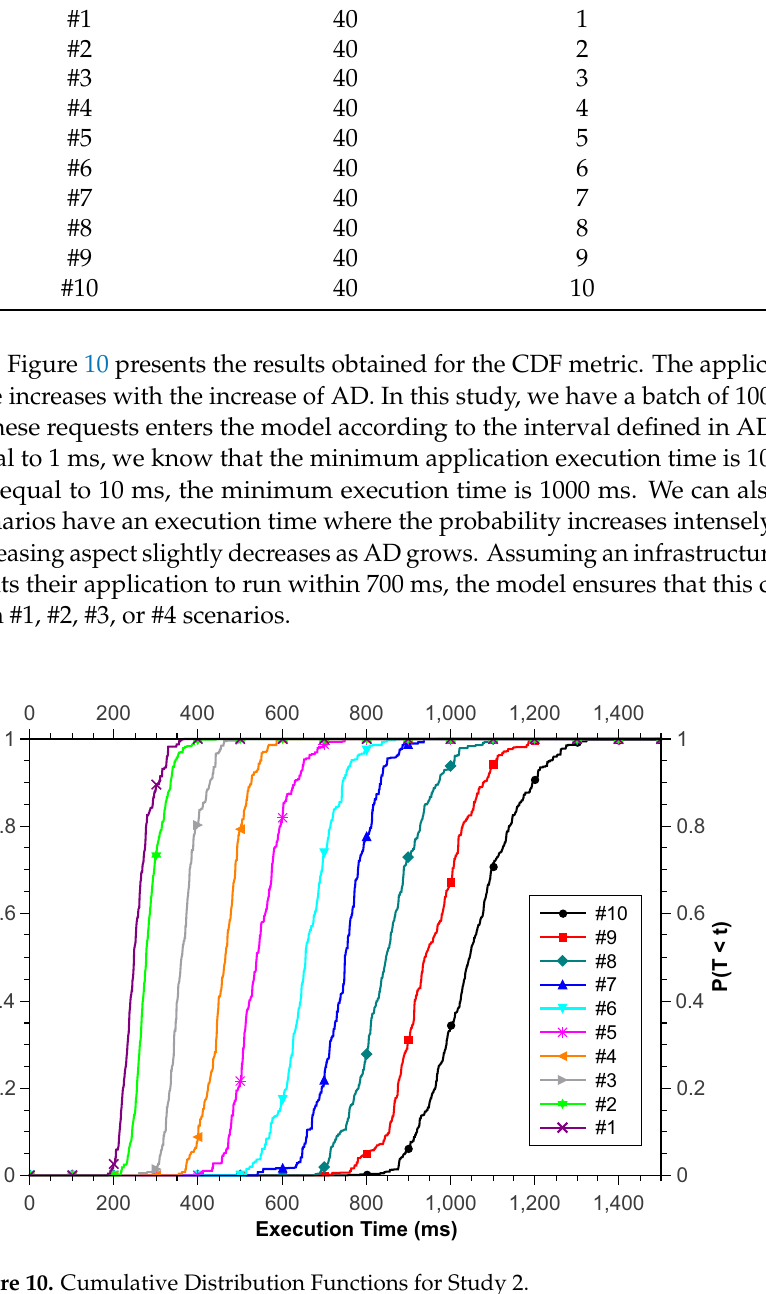
Figure 10. Cumulative Distribution Functions for Study